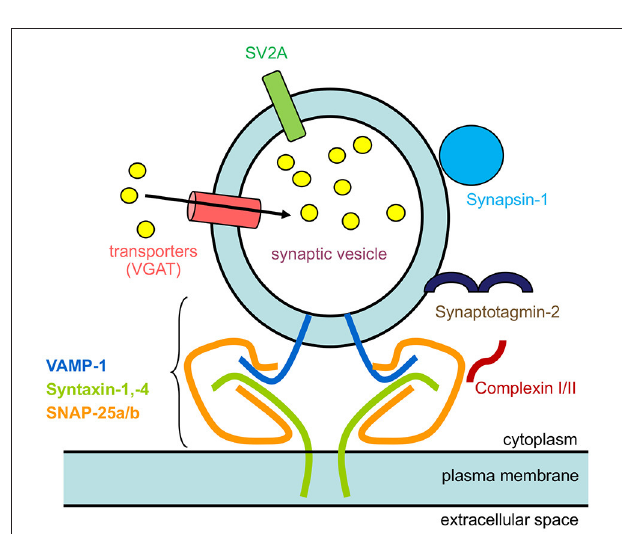
FIGURE 11 | Schematic of synaptic proteins found in mammalian horizontal cells. The diagram depicts a synaptic vesicle studded with synaptic vesicle proteins, VGAT, a neurotransmitter transporter, SV2A, Synaptotagmin-2, a calcium sensor, Synapsin I, and SNARE protein, VAMP-1. The other 2 SNARE proteins that form the minimal complex are Syntaxin-1, − 4, and SNAP-25, that brings the synaptic vesicle close to the plasma membrane for fusion. Finally, complexin-1/2 is a SNARE-associated protein. The yellow circles represent GABA that is accumulated inside synaptic vesicles by